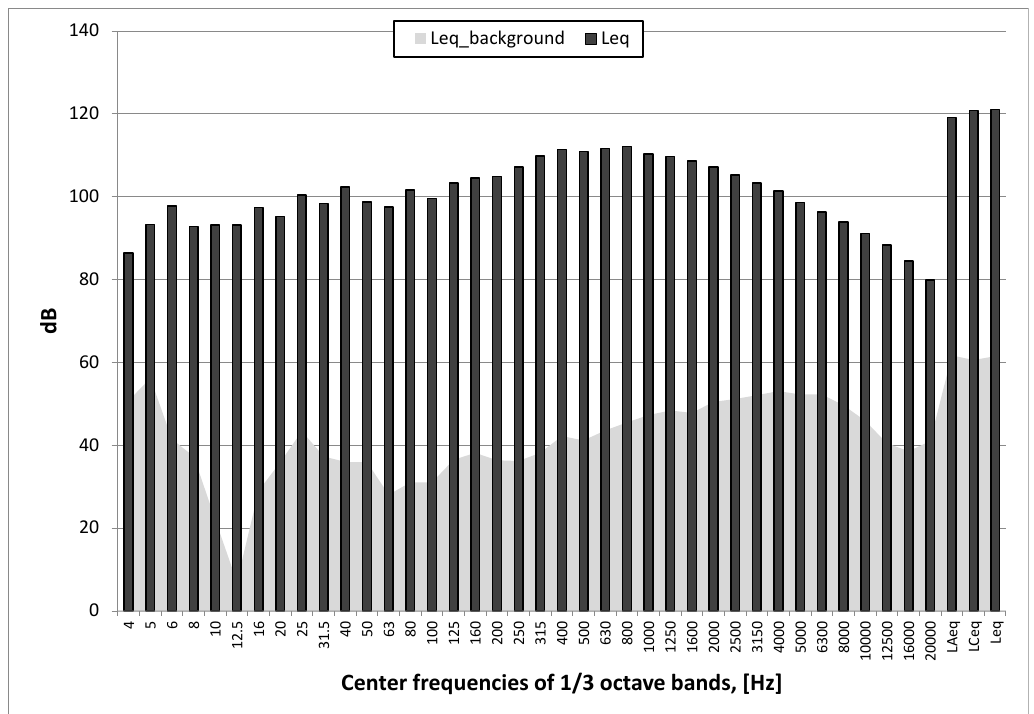
Figure 12. Test No. II: spectrum of maximum sound pressure level in 1/3 octave bands; pyrotechnic material explosion and background noise (Leq_background); stand 5.